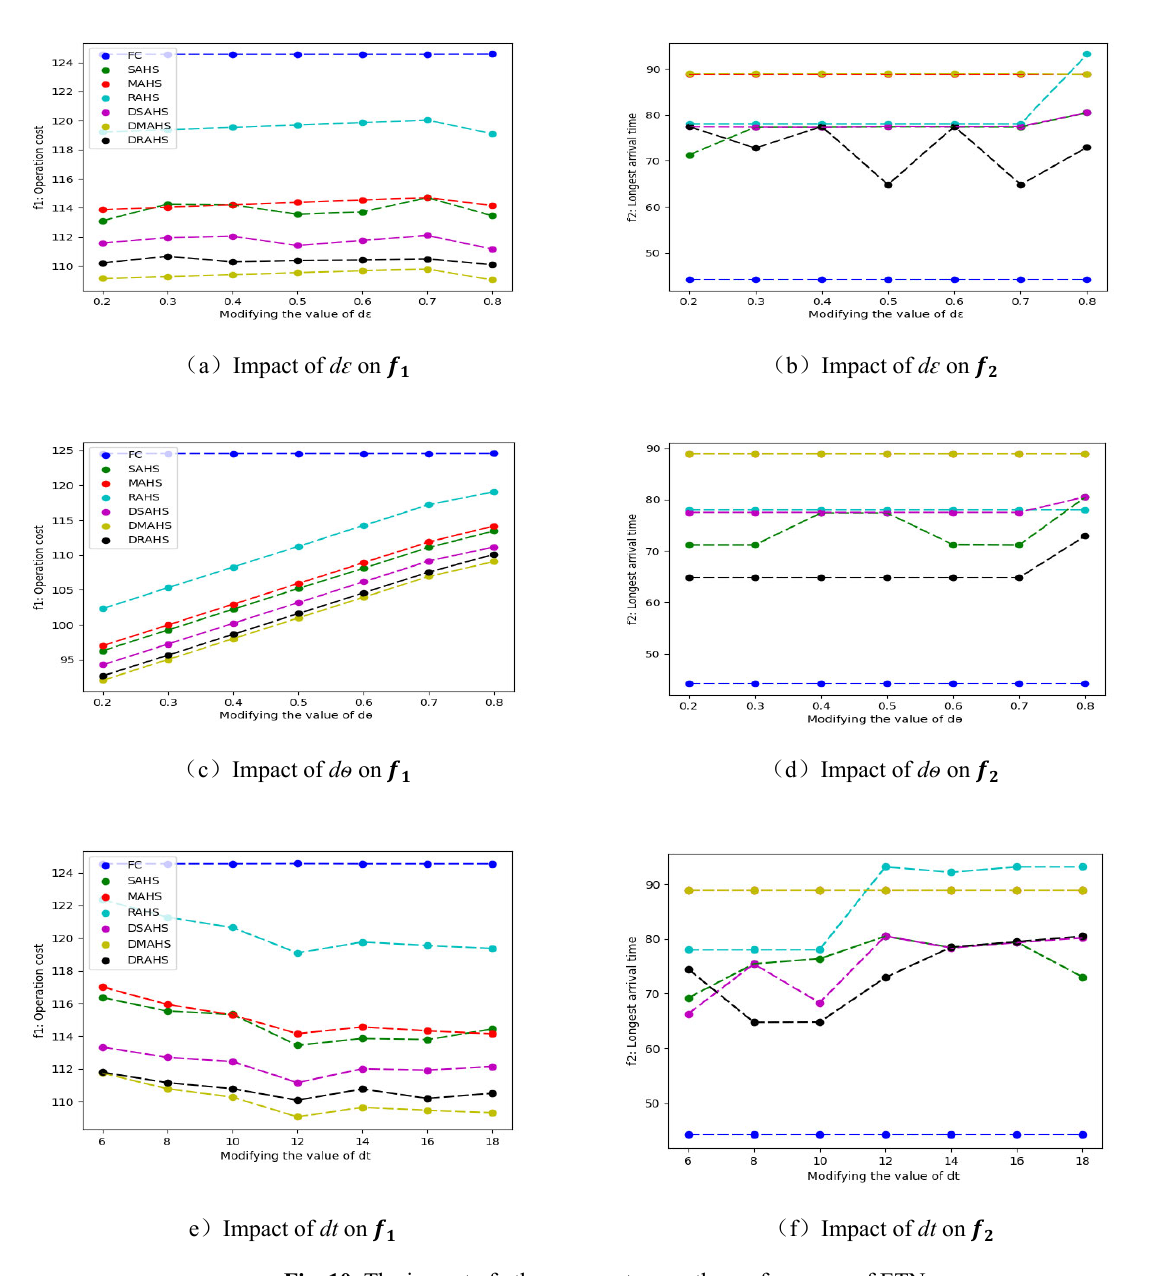
Fig. 10. The impact of other parameters on the performance of